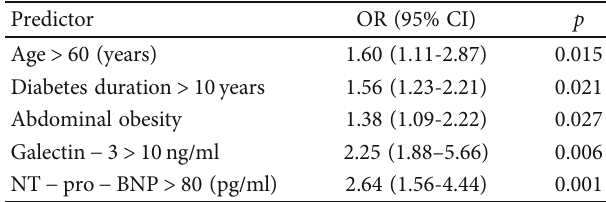
Table 2: Multiple logistic regression analysis for HFpEF incidence.